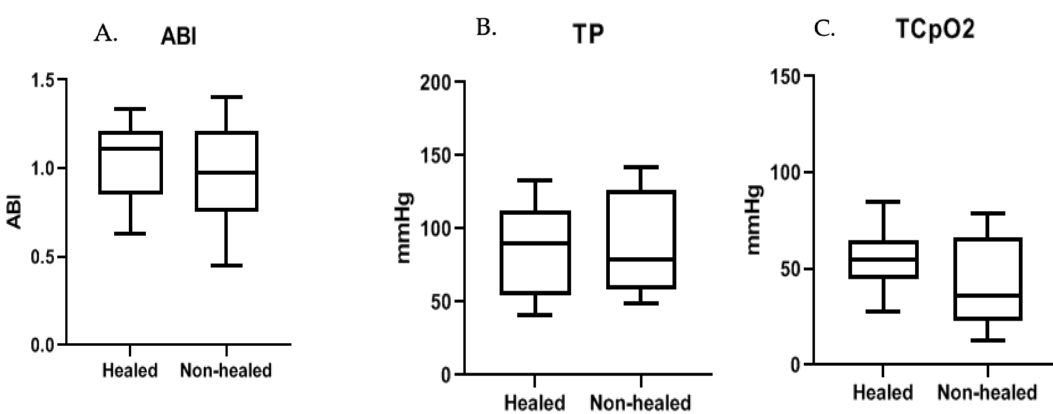
Figure 1. Box and whiskers ABI, TP and TCpO2. Box and whiskers of ( A ) ankle-brachial index (ABI), ( B ) toe-pressure (TP), and ( C ) transcutaneous oxygen tension measurement (TCpO2). NB. Please note different Y-axis scale between ( B ) and ( C ).